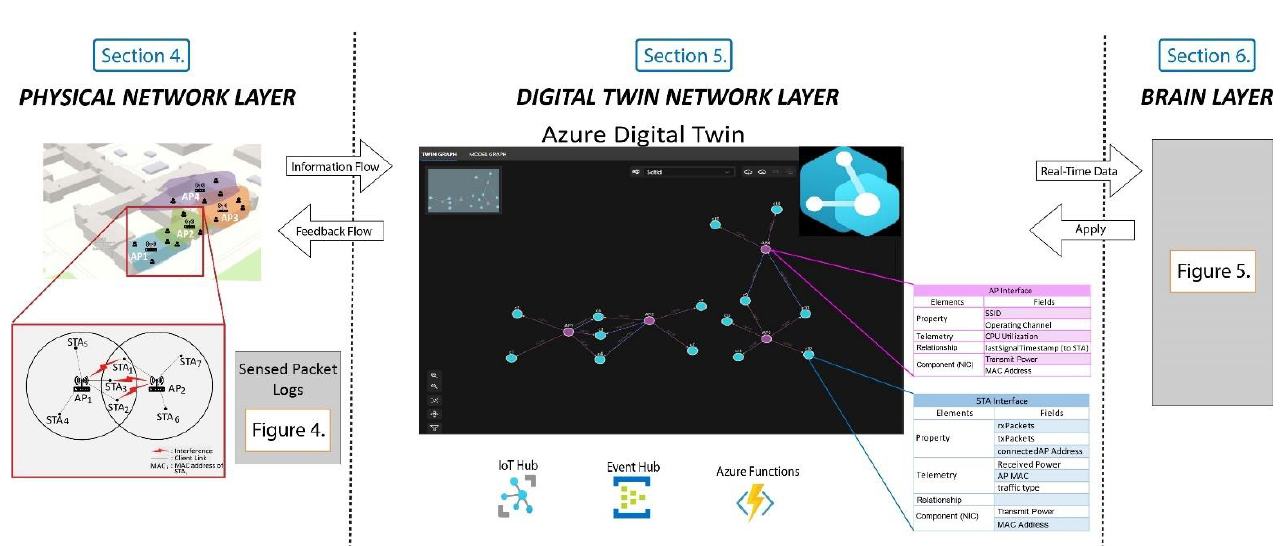
Figure 2. The proposed Digital Twin WiFi Network (DTWN)